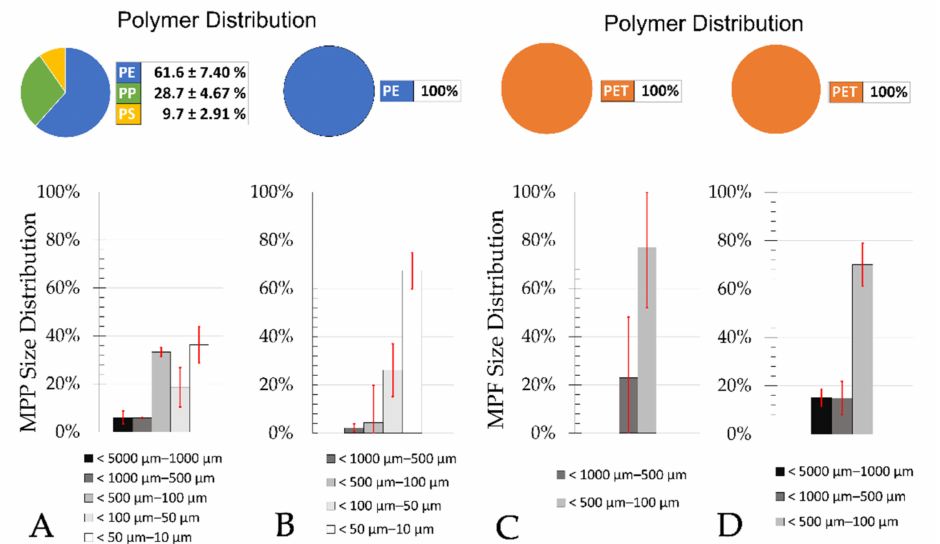
Figure 7. Average MPP polymer- and size distribution of the final clarifier effluent ( A ) and sand filter effluent ( B ) and average MPF polymer- and size distribution of the final clarifier effluent ( C ) and sand filter effluent ( D ) of the Frankfurt Sindlingen